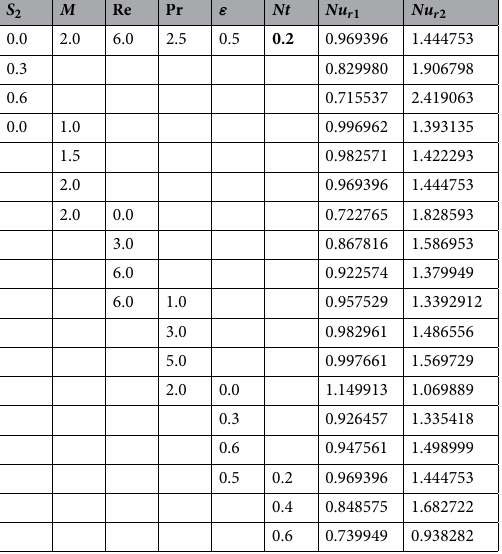
Table 4. The Nusselt numbers at lower Nu r 1 and upper Nu r 2 disks respectively, when